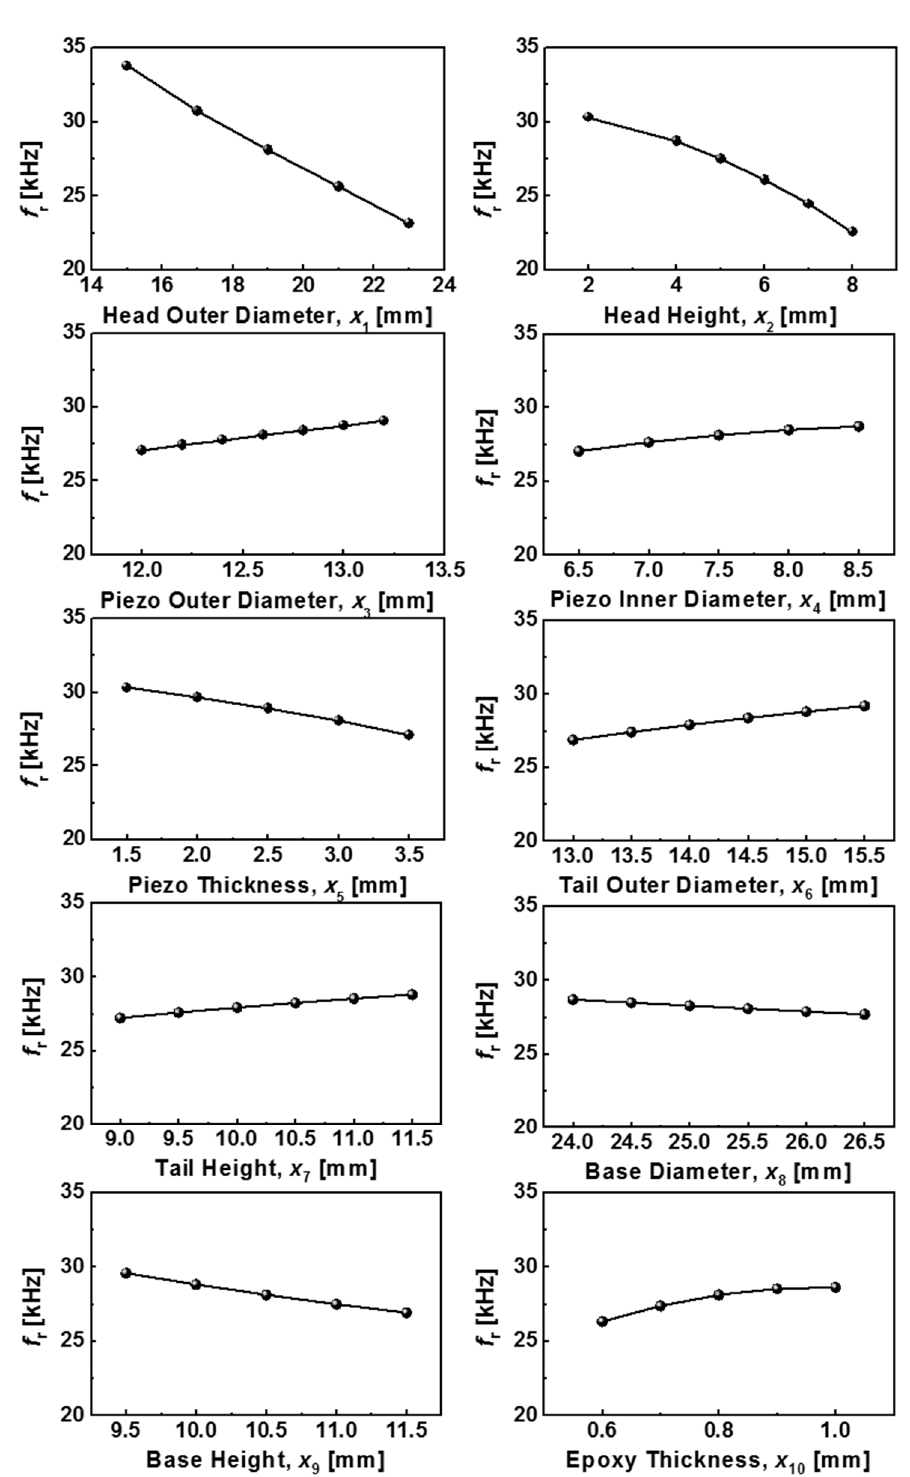
Figure 4. The changes of resonance frequency according to the values of each component constituting the sensor module.